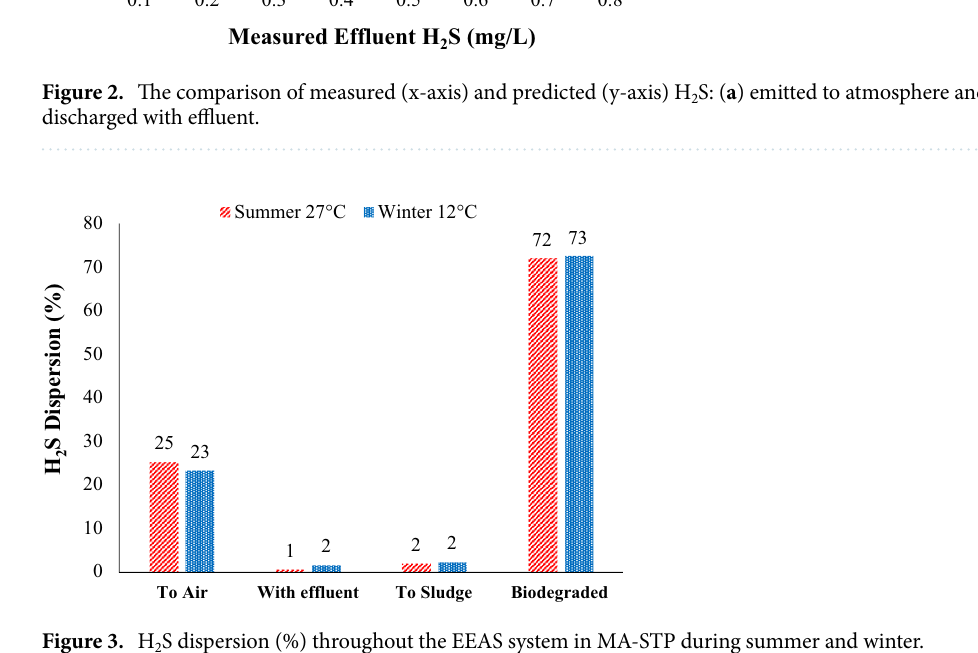
Figure 3. H 2 S dispersion (%) throughout the EEAS system in MA-STP during summer and